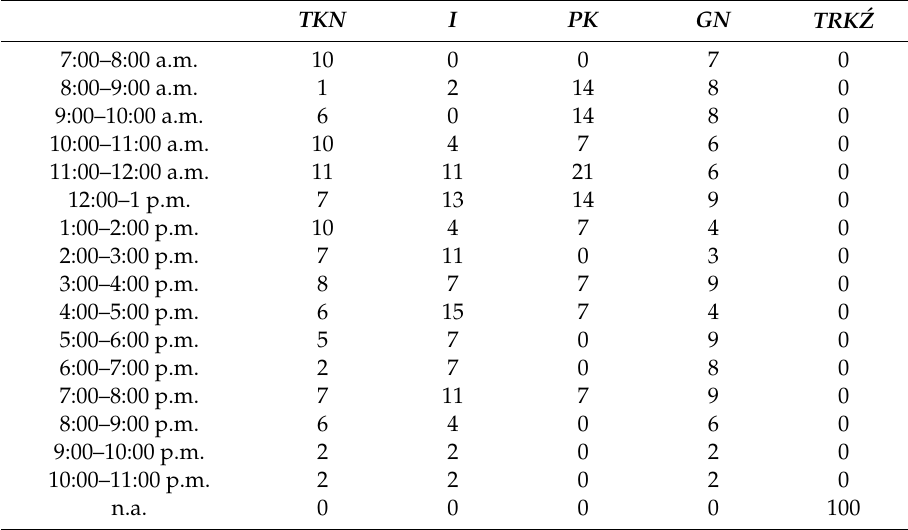
Table 5. Share of number of posts on FB at a given time throughout the week